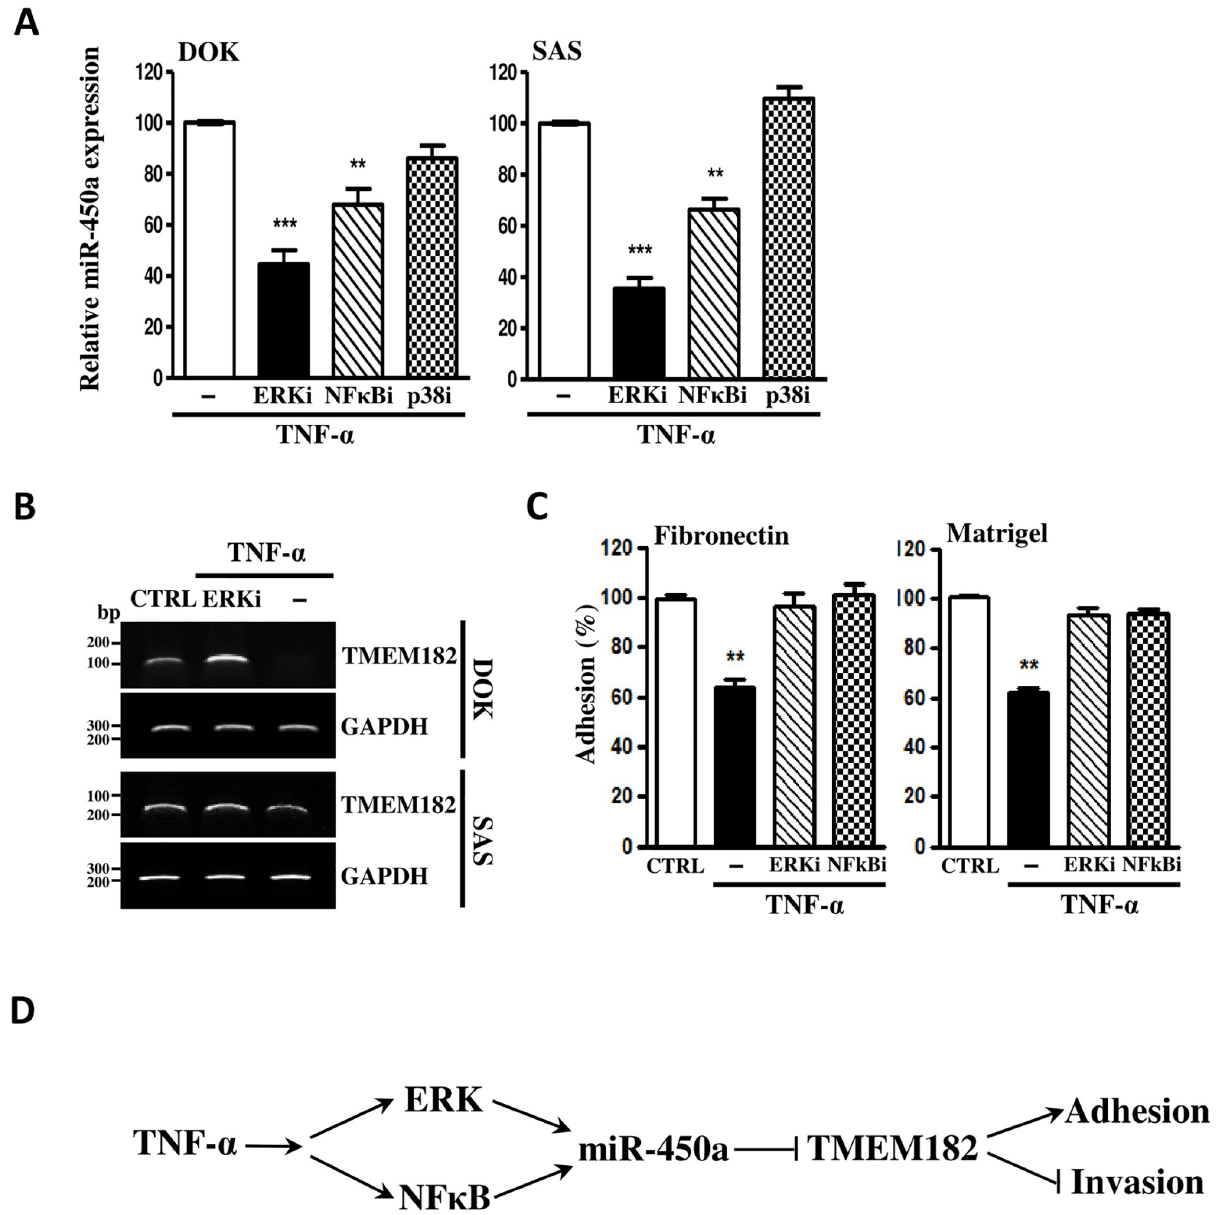
Fig 6. TNF α upregulates miR-450a versus ERK and NF κ B pathways to inhibit TMEM182 stabilized OSCC cells mobility. (A) OSCC cells were subjected into negative control DMSO (-), ERK inhibitor (ERKi), NF- κ B inhibitor (NF- κ Bi), or p38 inhibitor (p38i) as described above. After 6 hrs, TNF- α and ddH 2 O (negative control) were added as indicated treatments. Twenty-four hrs later, miR-450a levels were evaluated with qPCR. Levels of miR-450a in described conditions were standardized to negative controls (DMSO + ddH 2 O one). TNF- α only was used as reference. (B) RT-PCR analyses revealed that TNF- α suppressed TMEM182 expression in human OSCC cells was restored by ERKi. ddH 2 O and DMSO (-) were used as negative controls. GAPDH was used as the loading control. (C) Cell adhesion analyses revealed that ERKi or NF- κ Bi pretreated SAS cells successfully abolished TNF- α reduced cell adhesion ability. (D) TNF- α -induced miR-450a repressed TMEM182 expression to promote tumor malignancy through both intrinsic ERK and NF- κ B pathways. Results were represented as mean ± SEM; �� P < 0.01, ��� P < 0.001. performed genome-wide gene expression analysis using miR-450a transfected DOK and SAS cells. In silico analysis the expression signatures of miR-450a transfectants in OSCC cells and OSCC patients, we found that twelve genes were downregulation in clinical specimens and that they were candidate targets of miR-450a. Among these genes, transmembrane protein